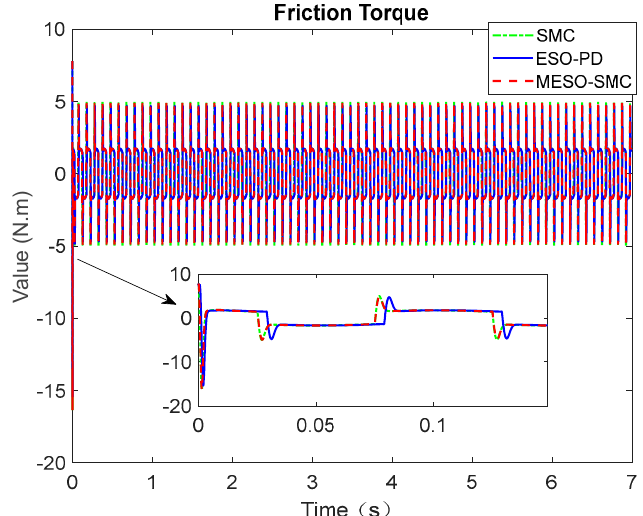
Figure 15. Friction torque curves.